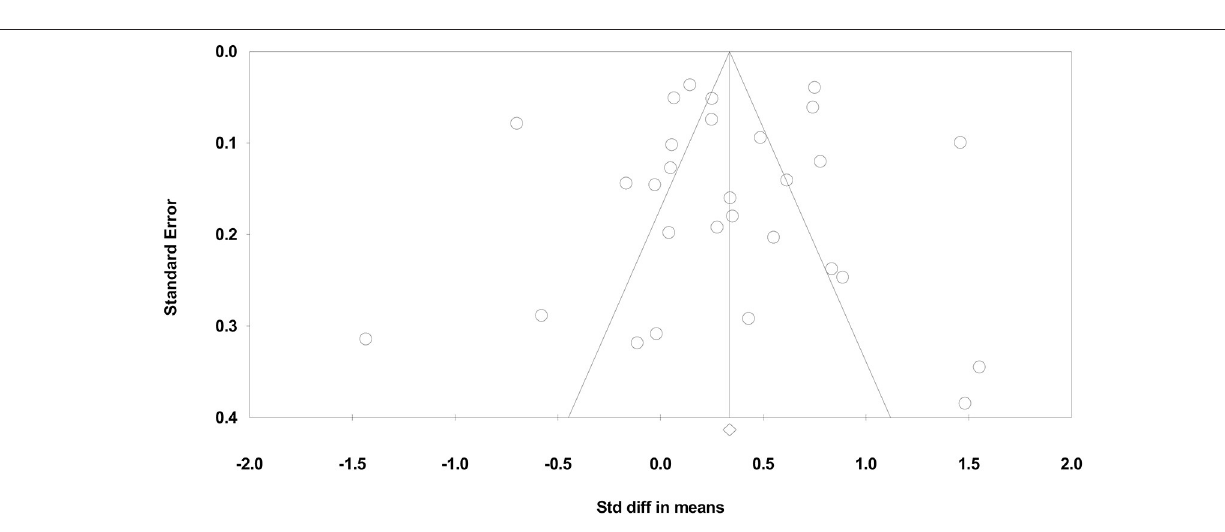
FIGURE 6 | Funnel plot of standard error by standardized difference in means of social PE